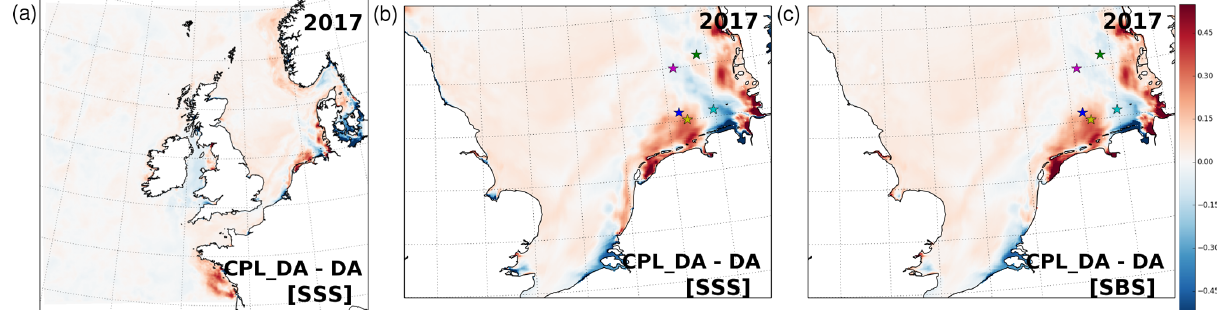
Figure 11. (a) Annual mean differences in simulated sea surface salinity (SSS) in CPL_DA relative to DA during 2017. (b) Zoom of annual mean SSS differences across the southern North Sea; and (c) differences in annual mean seabed salinity (SBS) in this region. The location of observing sites in the German Bight referenced in the text are shown (see also Fig.